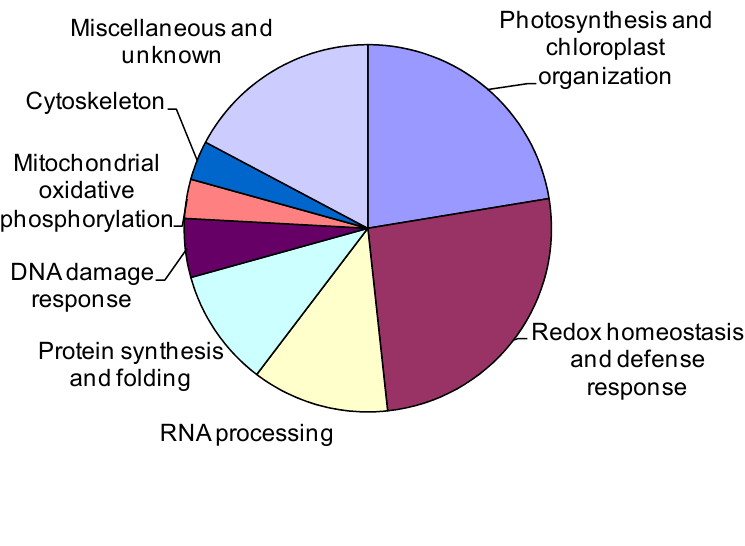
Figure 6. Functional distribution of 58 proteins differentially expressed in maize leaves under chromium stress. In total, eight functional groups are